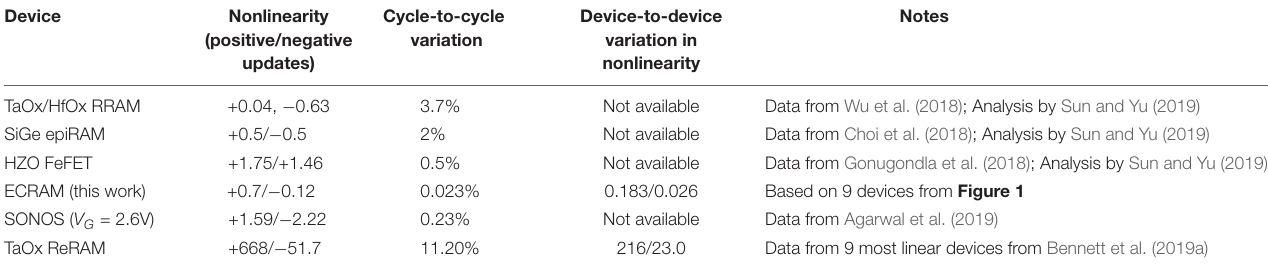
TABLE 1 | Quantitative comparison of non-volatile devices for training based on the analysis protocol developed by Sun and Yu (2019).